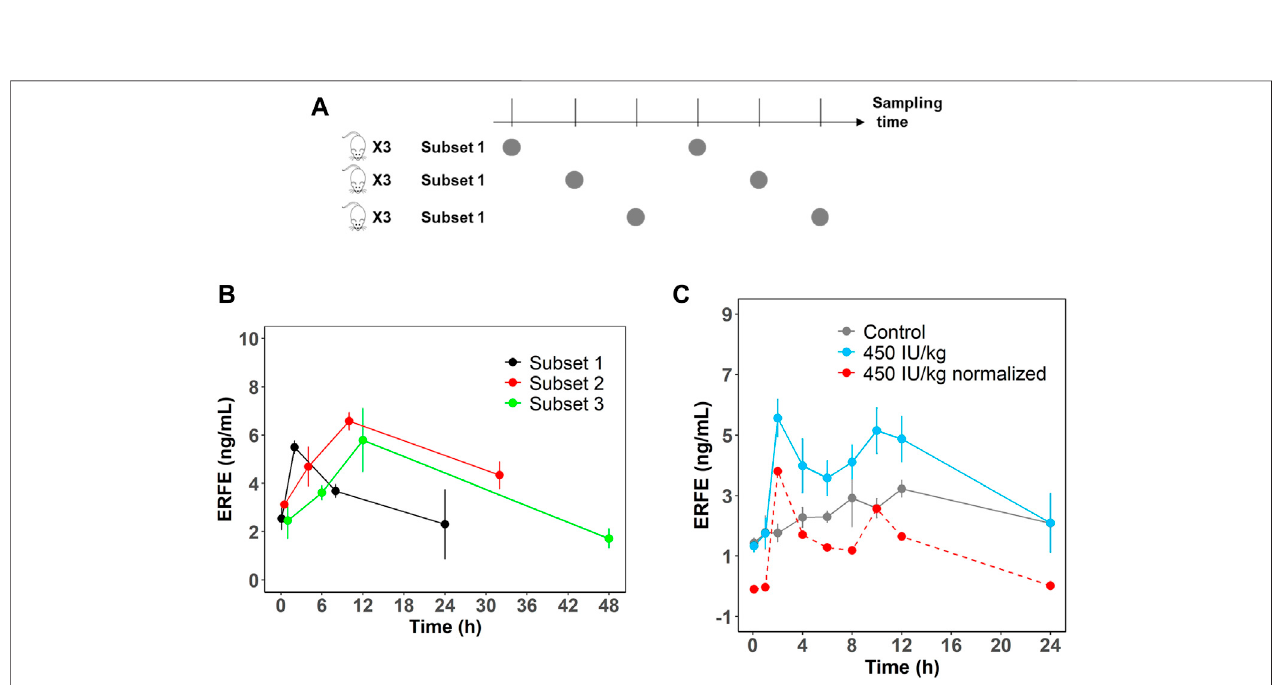
FIGURE 2 | (A) Schematic representation of the rotation manner of sampling for the fi rst six time points. A total of nine rats were divided into three subsets ( n = 3). (B) ERFE concentrations for each subset and for combined treatment group receiving 450 IU/kg rHuEPO. (C) Original ERFE concentration and normalized ERFE concentrations were measured in a dedicated study after 450 IU/kg rHuEPO treatment. ( n = 3 for each time point). Solid blue line indicates the original ERFE concentrationsandwaspresentedasmeans±SD;thereddashlineindicatesthemeanvalueofnormalizedERFEconcentrationsbysubtractingthemeanbaseline ERFE concentrations measured in the control group (solid gray